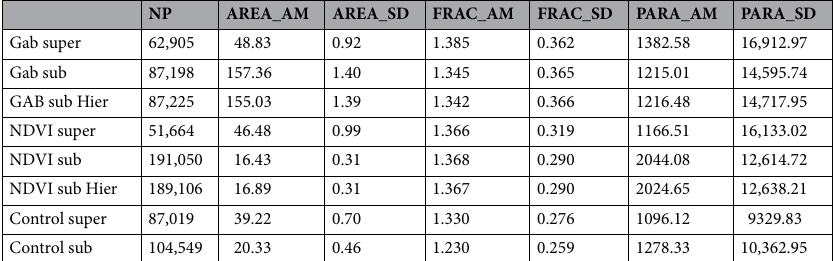
Table 3. Landscape metrics. Calculated landscape metrics for human segmented objects and all instances of the automated segmented objects. NP number of patches, AREA square area of patch (m 2 ), FRAC fractal dimension index of a patch, PARA perimeter area ratio of a patch, AM area weighted mean, SD standard